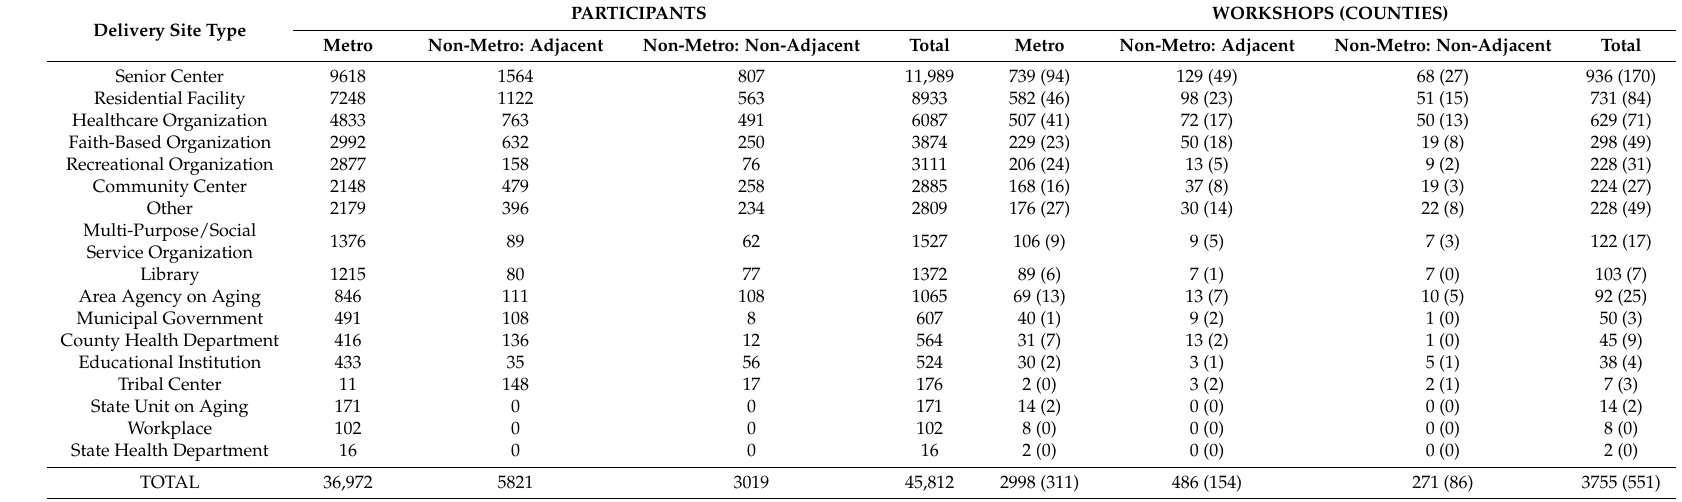
Table 2. Delivery Site Types by